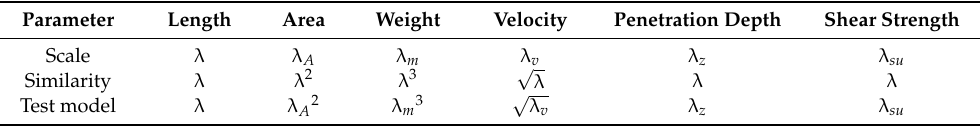
Table 8. Similarity relationship of the test model and the original model under the Froude criterion.